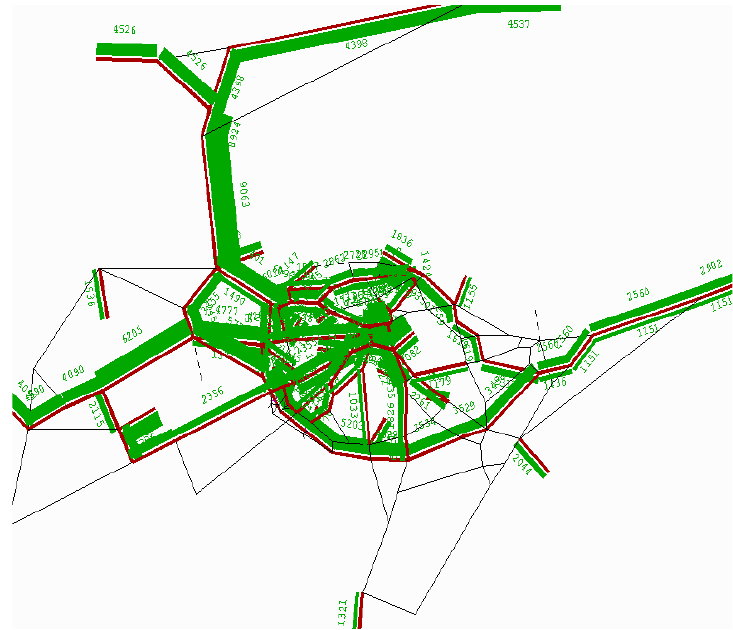
Figure 2. Example of select link analysis for cordon